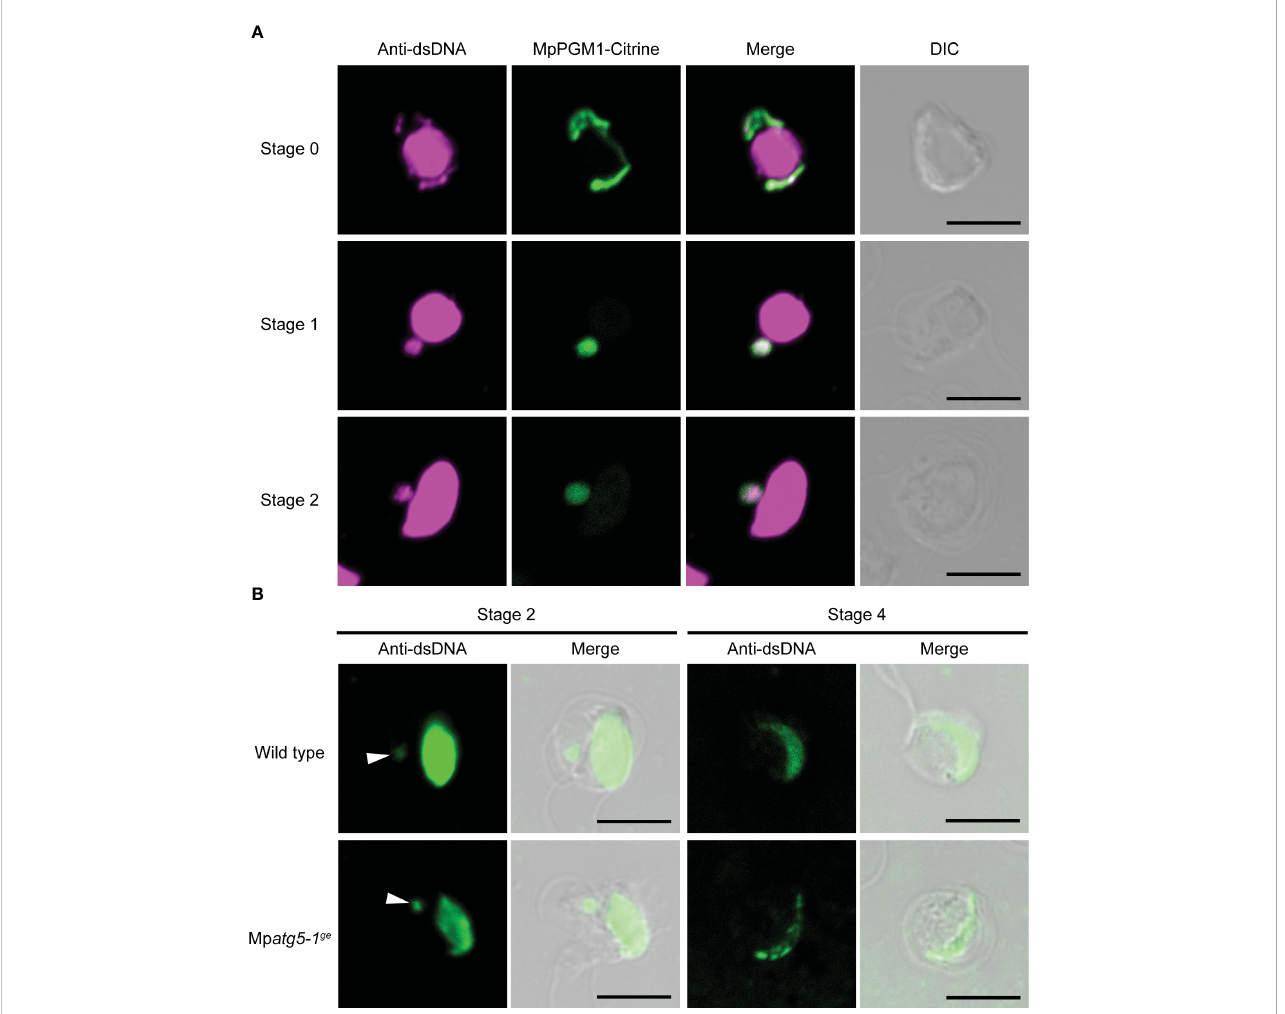
FIGURE 5 MpATG5-independent loss of plastid DNA during spermiogenesis. (A) Immunostaining of dsDNA (magenta) in wild-type antheridial cells expressing MpPGM1-Citrine (green). At least seven cells were observed at each stage and representative images are presented. Scale bars = 5 m m. DIC: differential interference contrast. (B) Immunostaining of dsDNA (green) in wild-type and Mp atg5-1 ge spermatids. Arrowheads indicate signals from plastid DNA. As a secondary antibody, Alexa Fluor 546 (A) or Alexa Fluor Plus 488 (B) was used. At least three cells were observed and representative images are presented. Scale bars = 5 m